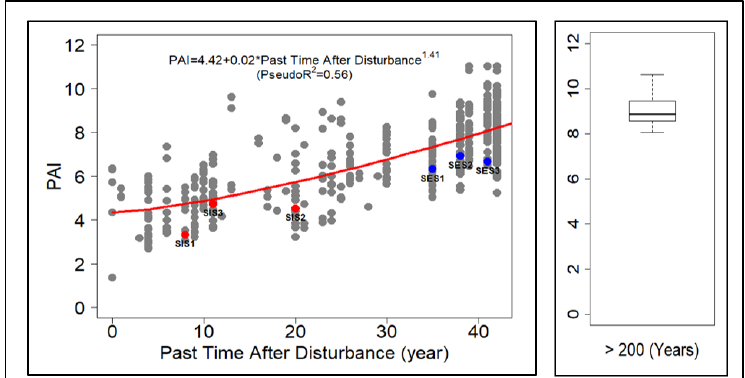
Figure 6. Relationship between the PAI estimated from the LiDAR and past time after disturbance (grey dots). The red line represents the fitted power model. Red dots represent the PAI of SIS in successional sample plots. Blue dots represent PAI of SES in successional sample plots. The box plots represent the PAI values of the OGS in Mo Singto plots with a forest age of ~ 200 years. The box edges indicate the 25th and 75th percentiles, the solid line indicates the median.